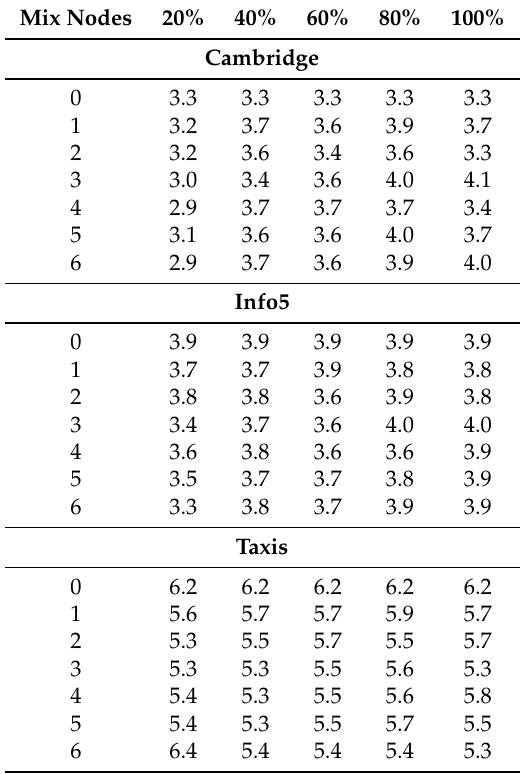
Table 5. Average routing-step path length with centrality mix